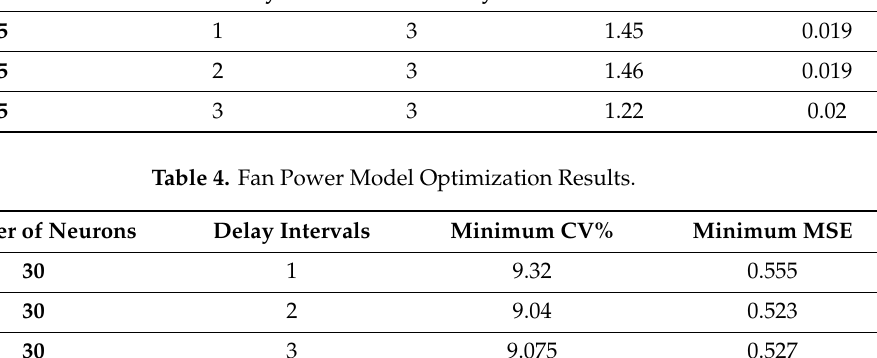
Table 3. Cooling Coil Model Optimization Results.